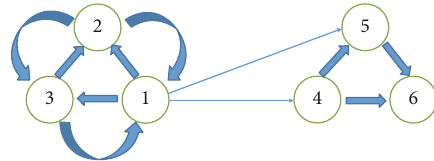
Figure 1: The figure displays the graph associated with model